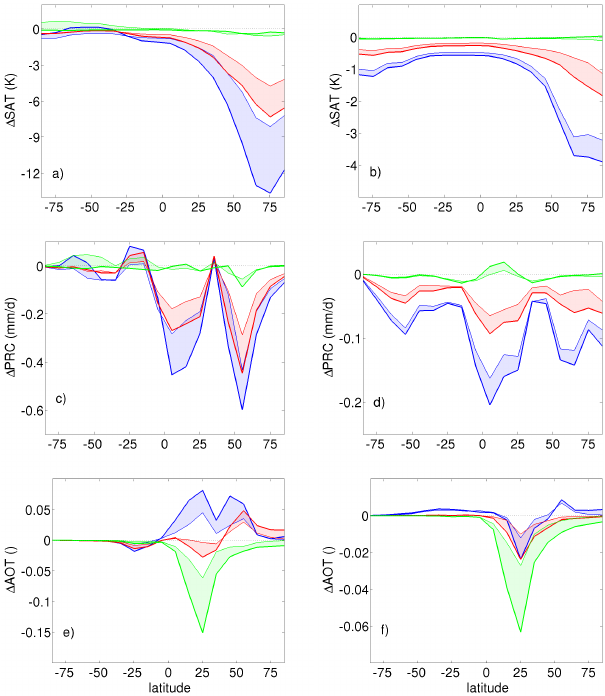
Figure 10. Zonal means of response to dust SW DRF from six simulations experiments for SAT in K (a, b) , precipitation in mmd − 1 (c, d) and dust AOT (e, f) for 21kyr (a, c, e) and 0ka (b, d, f) . Note responses of SAT and precipitation are relative to control simulation and responses of dust AOT are relative to corresponding solutions L1 and L2 shown in Fig. 6a, b. Color shading and line width as in Fig. 5.